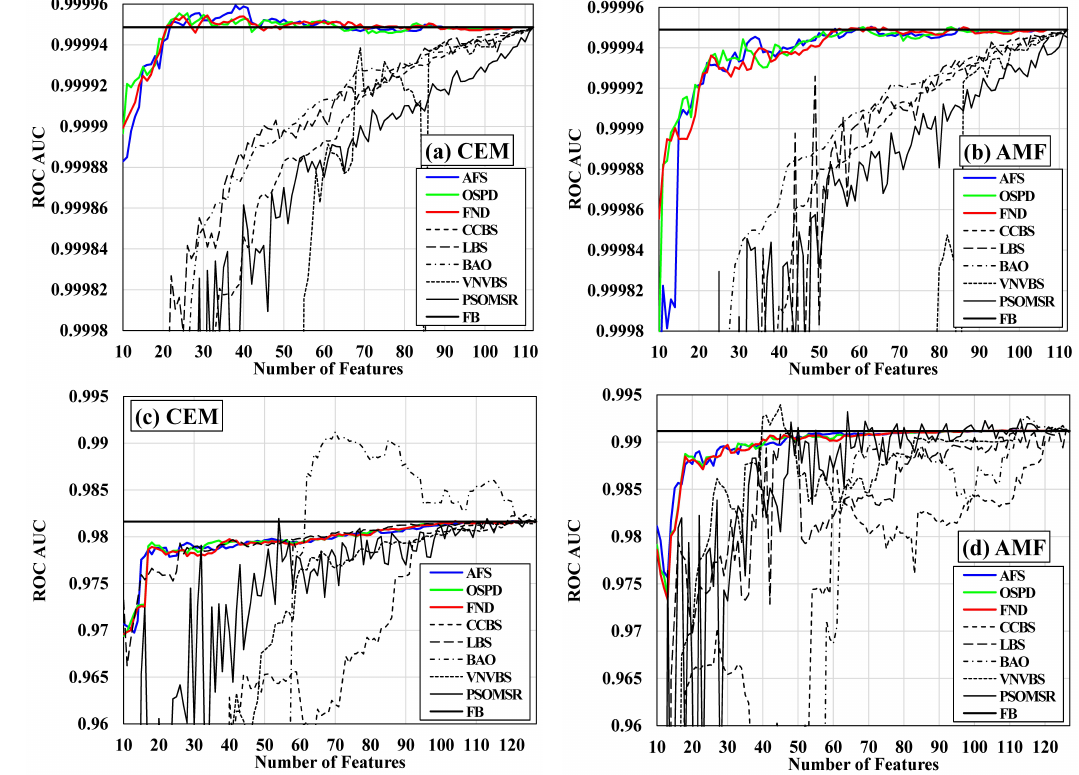
Figure 12. The receiver operating characteristics area under the curve (ROC AUC) versus the number of optimal features in each feature subset using the CEM and AMF detectors. Figure ( a , b ) show the results of the HyMap dataset; figure ( c , d ) show the results of the SIM.GA dataset. The curves in solid color lines are generated by the proposed FS methods. The black horizontal lines indicate the full-band result.